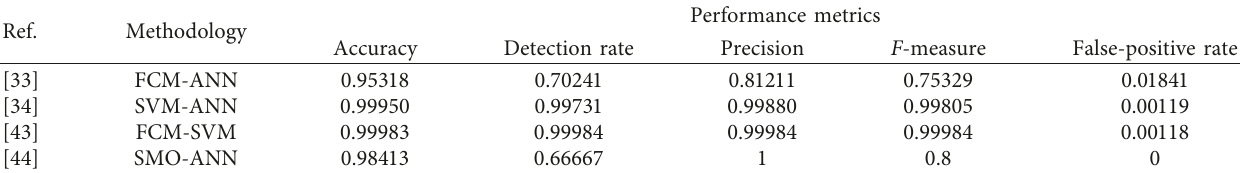
Table 9: Comparison of various methodologies based on different performance metrics for generic attack.